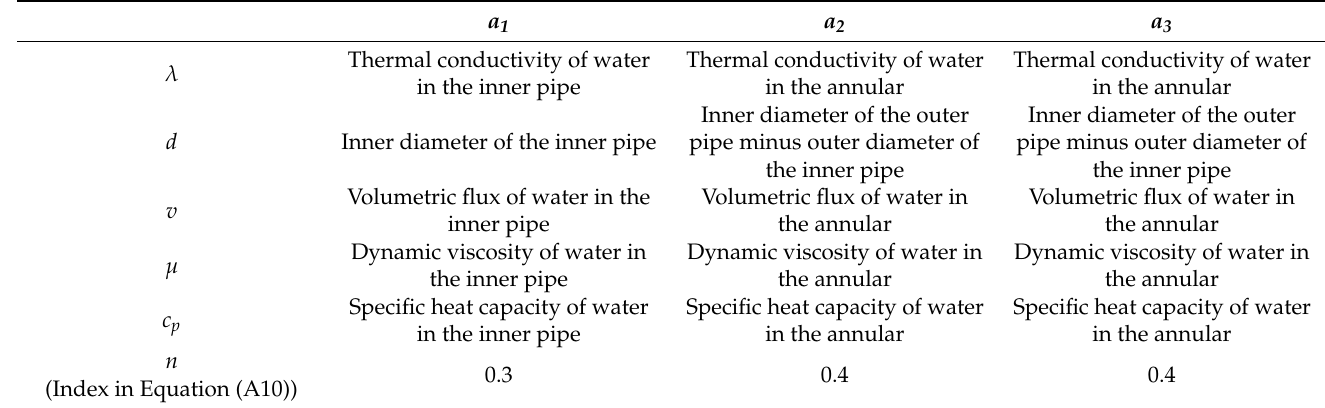
Table A1. Parameters used for determining the convective heat transfer